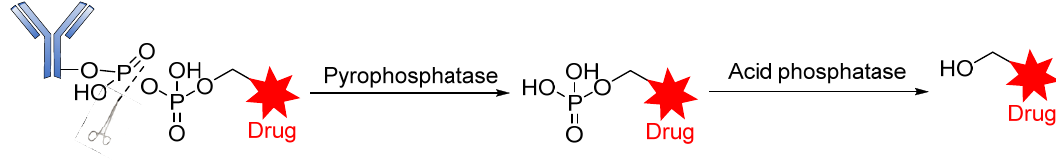
Figure 15. The mechanism by which an ADC containing pyrophosphate is released.